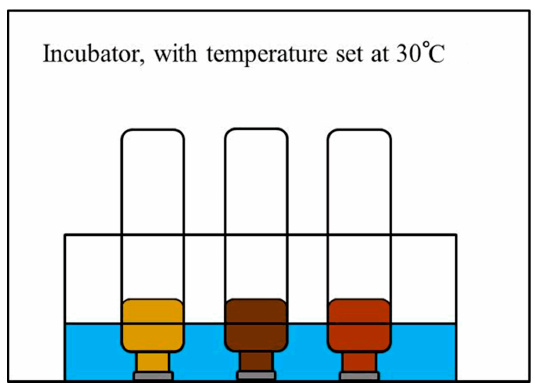
Figure 1. Experimental set-up used to assess hydrocarbon decomposition within a temperature controlled incubator.